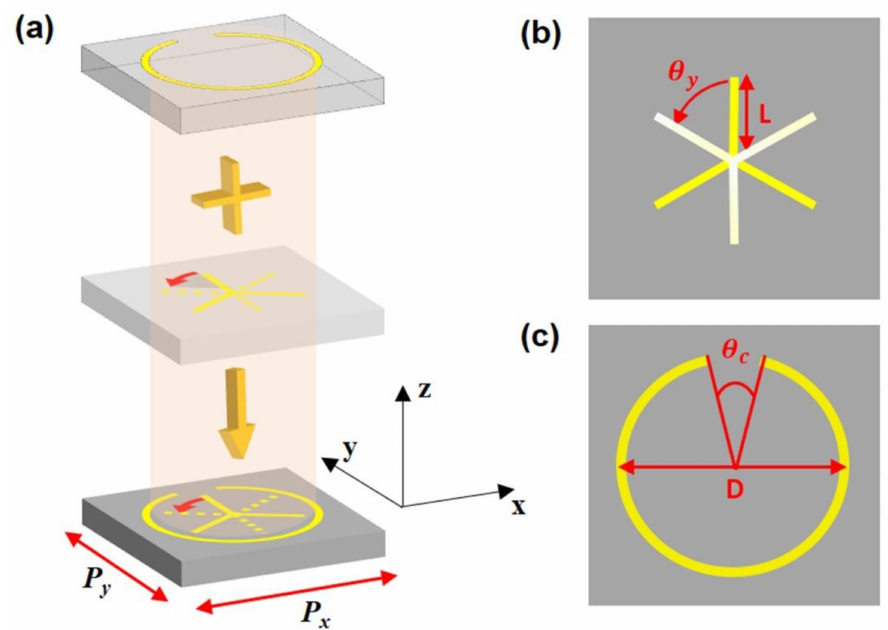
Figure 1. ( a ) Schematic of the THz planar meta-rotamer consisting of the C-shaped SRR and Y-shaped metal rod. The physical dimensions of the meta-molecules in the lattice are P x = P y = 120 µ m. The thicknesses of the meta-molecules and dielectric substrate (bare silicon) are 150 nm and 200 µ m, respectively. ( b ) Schematic of the Y-shaped meta-atom. The corresponding size and rotations are as follows: L = 40 µ m; θ y = 0 ◦ , 30 ◦ , and 60 ◦ . ( c ) Schematic of the C-shaped SRR meta-atom. The corresponding size and angular gaps are as follows: D = 100 µ m; θ c = 10 ◦ , 20 ◦ , and 30 ◦